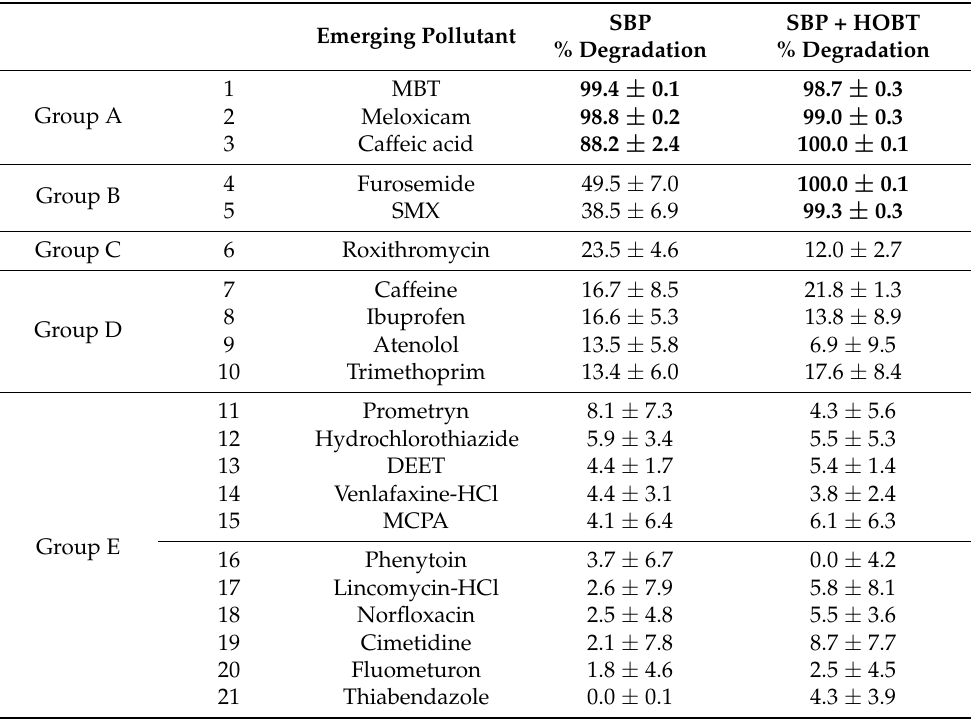
Table 1. Degradation of 21 Eps by SBP ±